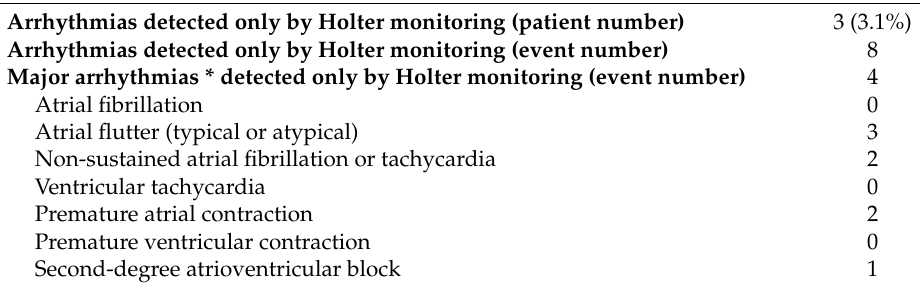
Table 4. Detection of arrhythmias by the w-ECG that resulted in therapeutic interventions. N Detected Arrhythmia